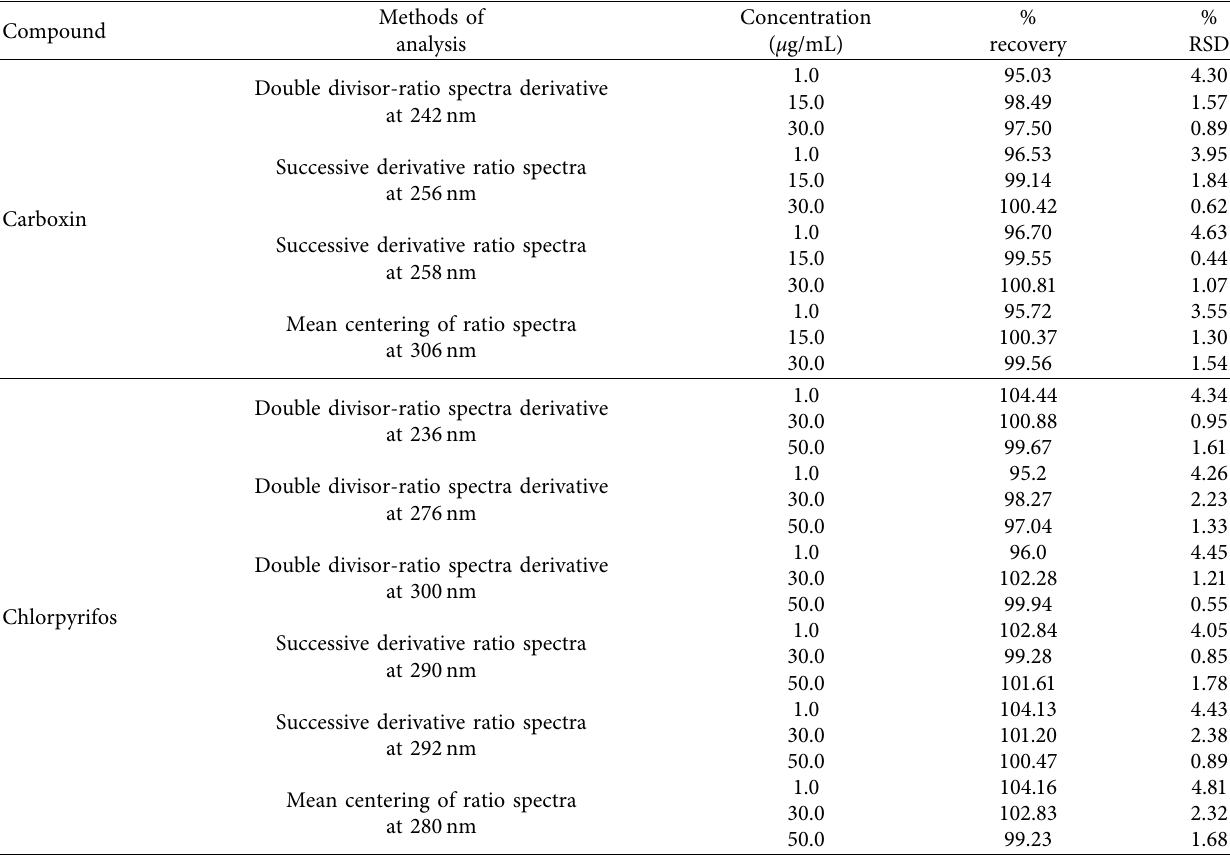
Table 2: Accuracy and precision for simultaneous determination of carboxin, chlorpyrifos, and tebuconazole in the ternary mixture by the proposed